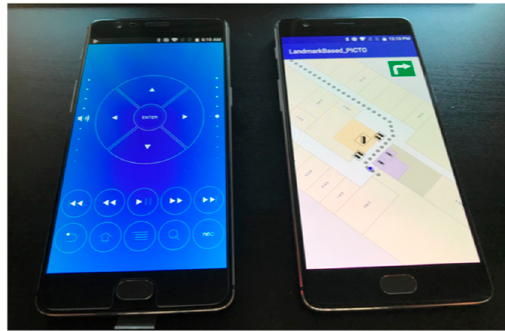
Figure 5. Two android devices connected via Tablet Remote APK (via Bluetooth).